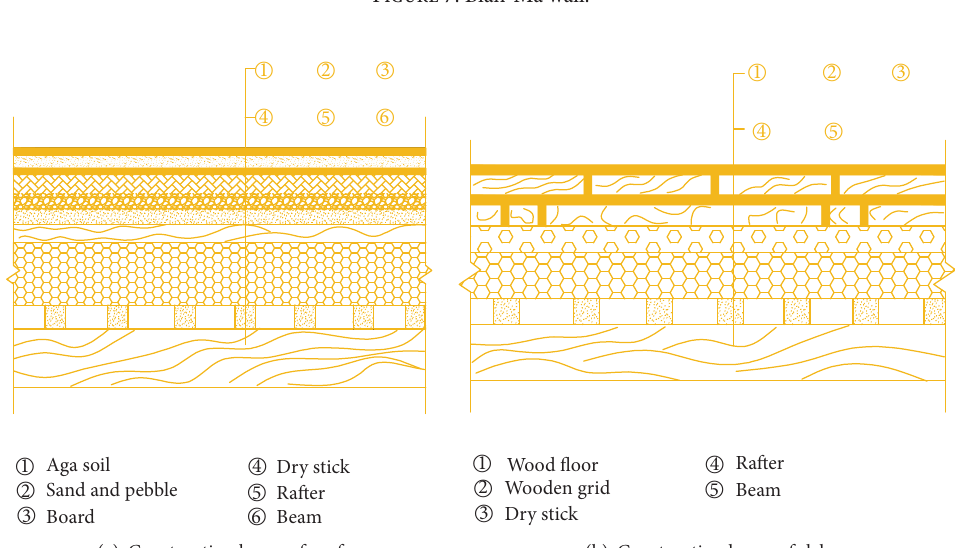
Figure 7: Bian-Ma wall.